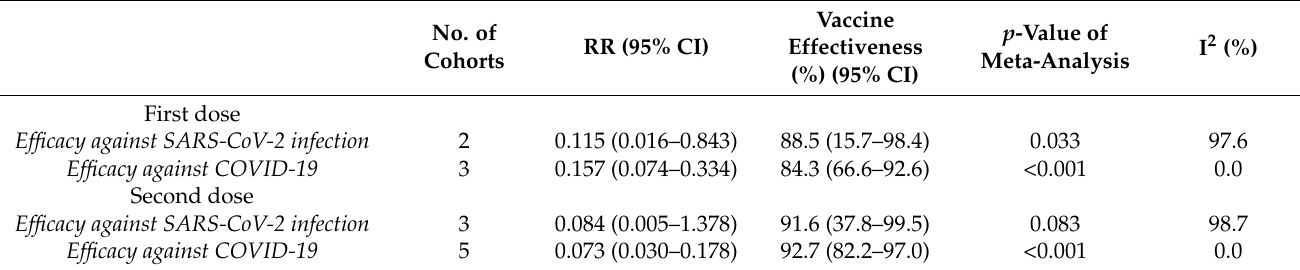
Table 1. Vaccine effectiveness of SARS-CoV-2